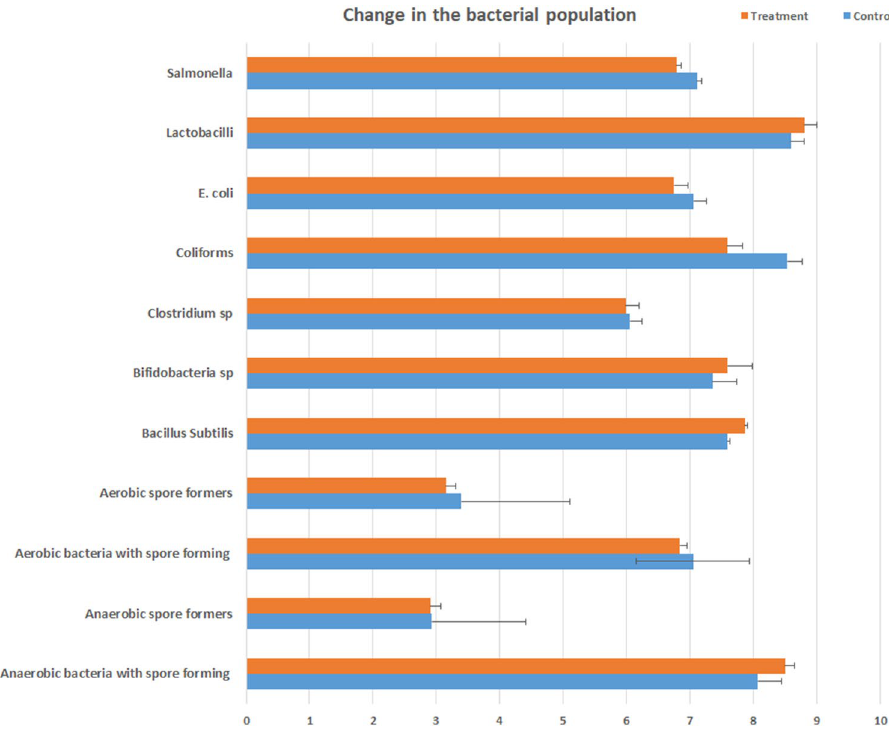
Figure 5. Change in the composition of the gut bacterial population upon enzyme supplement.